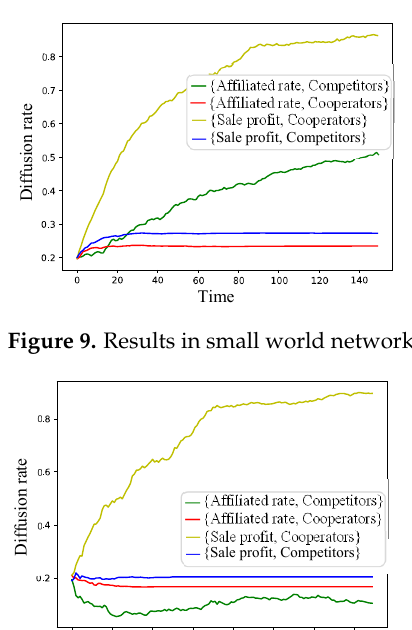
Figure 8. Results in scale free network.